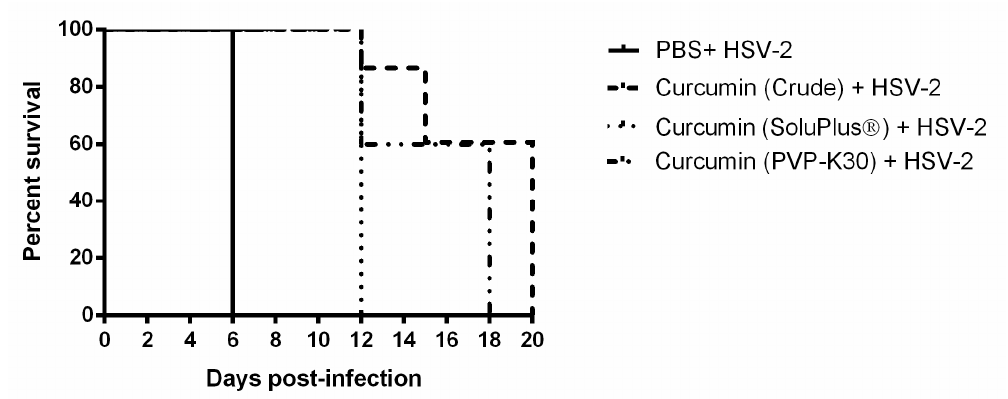
Figure 6. Survival of mice in response to high-dose HSV-2 infection after treatment with crude or solubilized curcumin. Depo-treated mice (n = 5–15 per group) received IVAG inoculation with either PBS or 1 mg of crude curcumin or 100 µ g of curcumin in PVP-K30- or Soluplus ® -based solid dispersion formulations and, after 6 h, were infected with 5 × 10 4 PFU / mouse of HSV-2 virus IVAG. Survival was monitored for 20 days post-infection and is displayed as % survival per day post-infection. Di ff erences were statistically significant by the Mantel–Cox log-rank test: HSV-2 alone vs. crude curcumin: p < 0.0001, HSV-2 alone vs. Soluplus ® curcumin: p = 0.0027, HSV-2 alone vs. PVP-K30: p = 0.0002, PVP vs. Soluplus ® : p = 0.0308, Crude vs. Soluplus ® : p = 0.0006, and Crude vs. PVP: p = 0.0457. Table 4. Cumulative pathology for mice pre-treated intravaginally with crude or solid dispersion formulations of curcumin and infected with HSV-2. Pre-Treatment